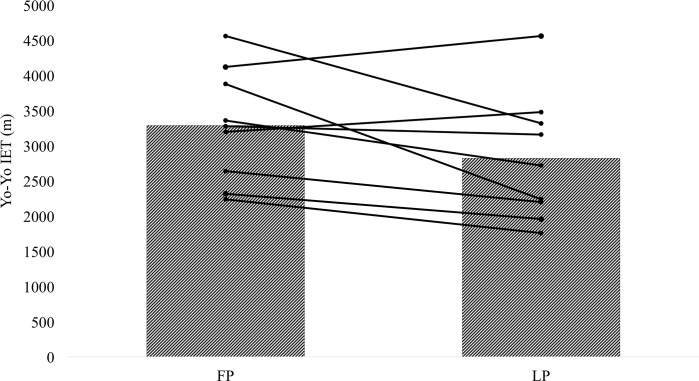
Mean meters of completion during the Yo-Yo IET during the two phases of the menstrual cycle.The data for each individual has been superimposed onto each group mean. The menstrual phases are abbreviated as FP (early follicular phase) and LP (mid luteal phase).